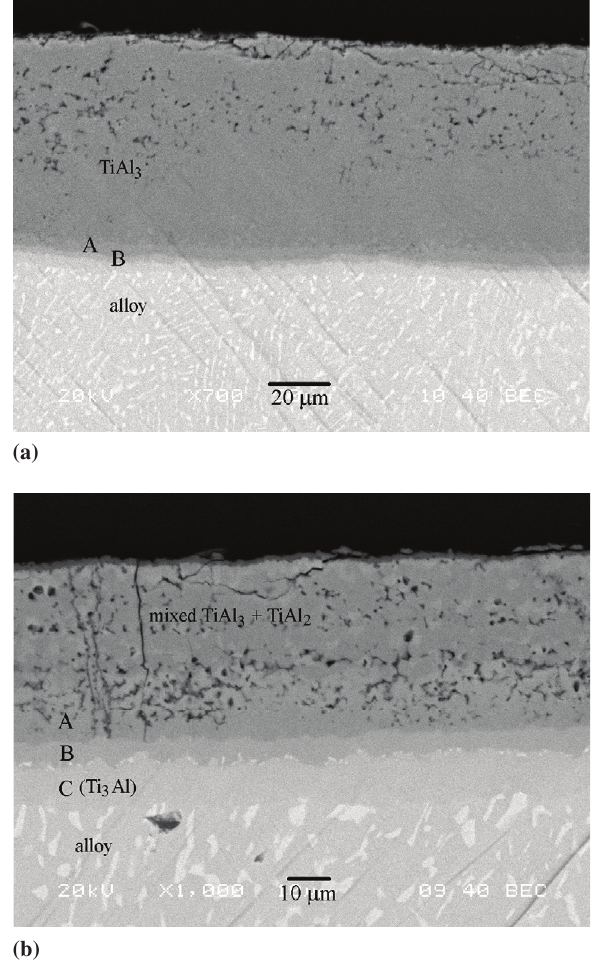
Figure 6. Micrographs of cross-section of the coating/TA15 after interrupted oxidation for 300 h in air. (a) 973 K; (b) 1073 K. A represents TiAl 2 , and B represents